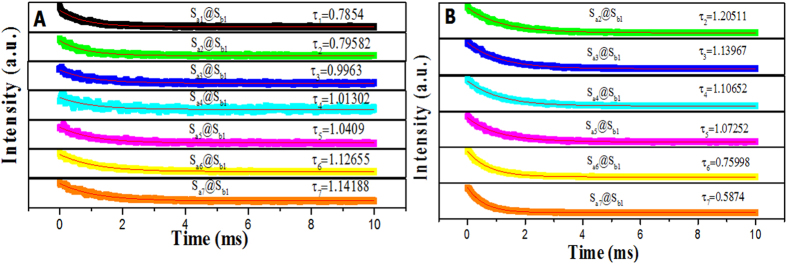
Fluorescence decay dynamics of the 4F9/2→6H13/2 transitions of Dy3+ (λem = 574 nm) (A) and the 5D0→7F2 transitions of Eu3+ (λem = 616 nm) (B) in samples Sax@Sb1 (x = 1–7).